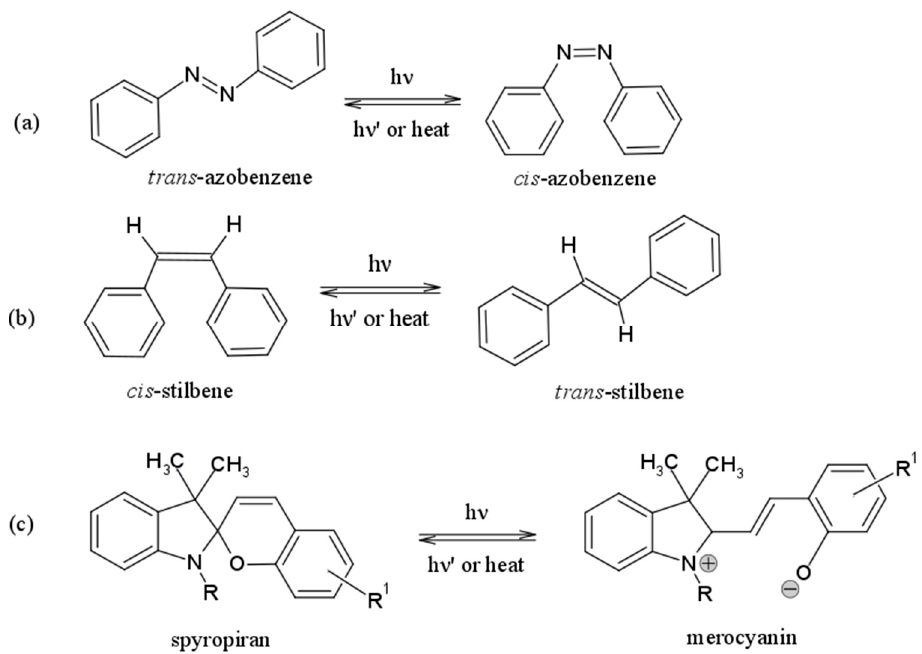
Figure 1. Photo-isomerization mechanism of photochromic molecules: ( a ) azobenzene; ( b ) stilbene; and ( c ) spiropyrane.